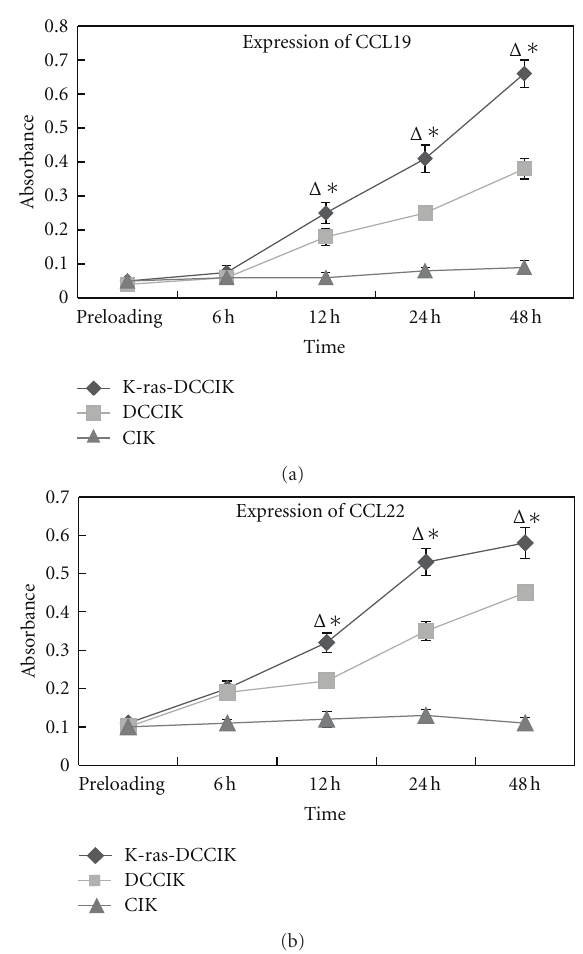
Figure 2: The absorbances of CCL19 and CCL22 at di ff erent time points (experiment 2.6). The expression of CCL19 and CCL22 in group K-ras-DCCIK and DCCIK showed uptrend with time and were higher than those of group CIK except for preloading and the 6-hour point. K-ras-DCCIK DCCIK versus CIK after 12 h, ∗ P < 0 . 01. K-ras-DCCIK versus DCCIK after 12h, P < 0 . 05. But the expression in group CIK showed no apparent increase (Figures 2(a) and